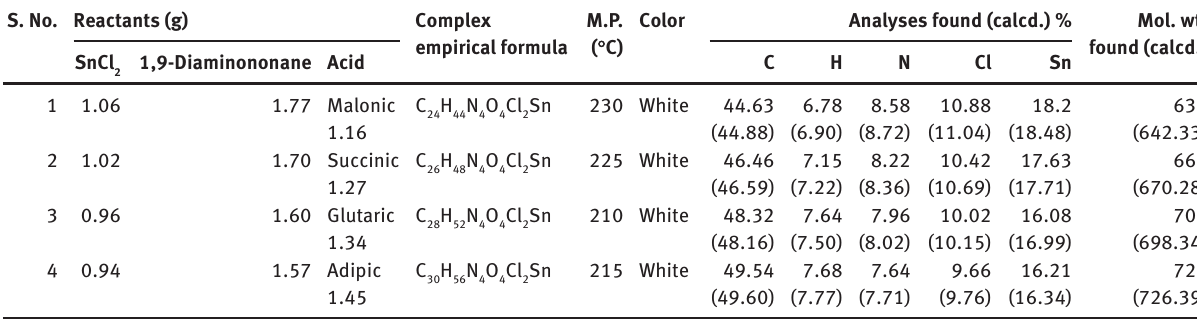
Table 1 Physical properties and analytical data of tin(II) macrocyclic complexes. S. No. Reactants (g)